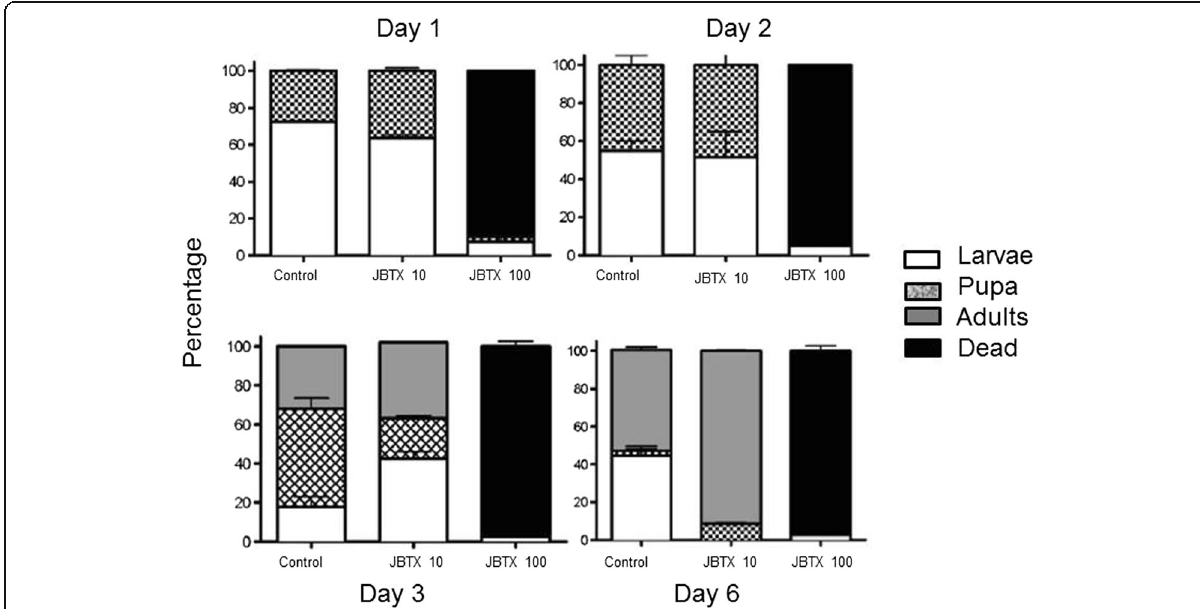
Fig. 1 Effects of jaburetox-V5-loaded lyophilized E. coli on A. aegypti . Mosquito larvae, 25 per experimental condition, were fed fish diet soaked with a suspension of lyophilized E. coli cells containing 0 (control), 10 or 100 μ g of JBTX, as quantified by ELISA. Controls with non-transformed E. coli were run in parallel. The larvae were kept at 28 o C with a photoperid of 8:16 (light:dark) and developmental stage and mortality were recorded daily up to day 6. The results are average of duplicates, and expressed as a percentage relative to the initial number of insects. Copyright by K. Kappaun [19]. Reprinted with